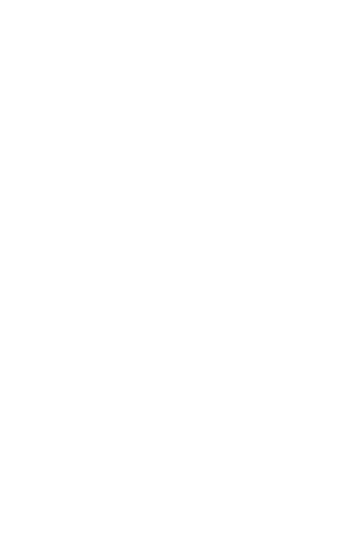
Table 2. Annotation about cell clusters in CRC